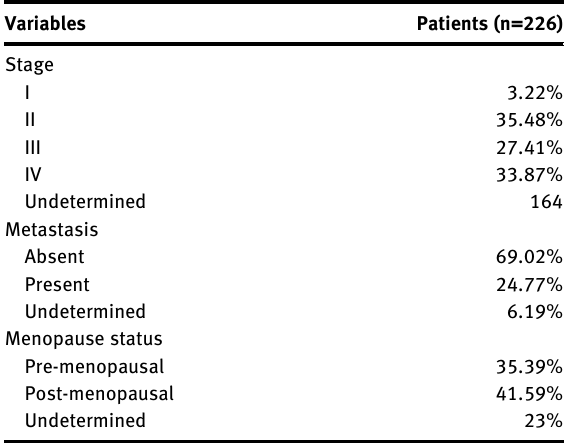
Table  : Clinical data of breast cancer patients.